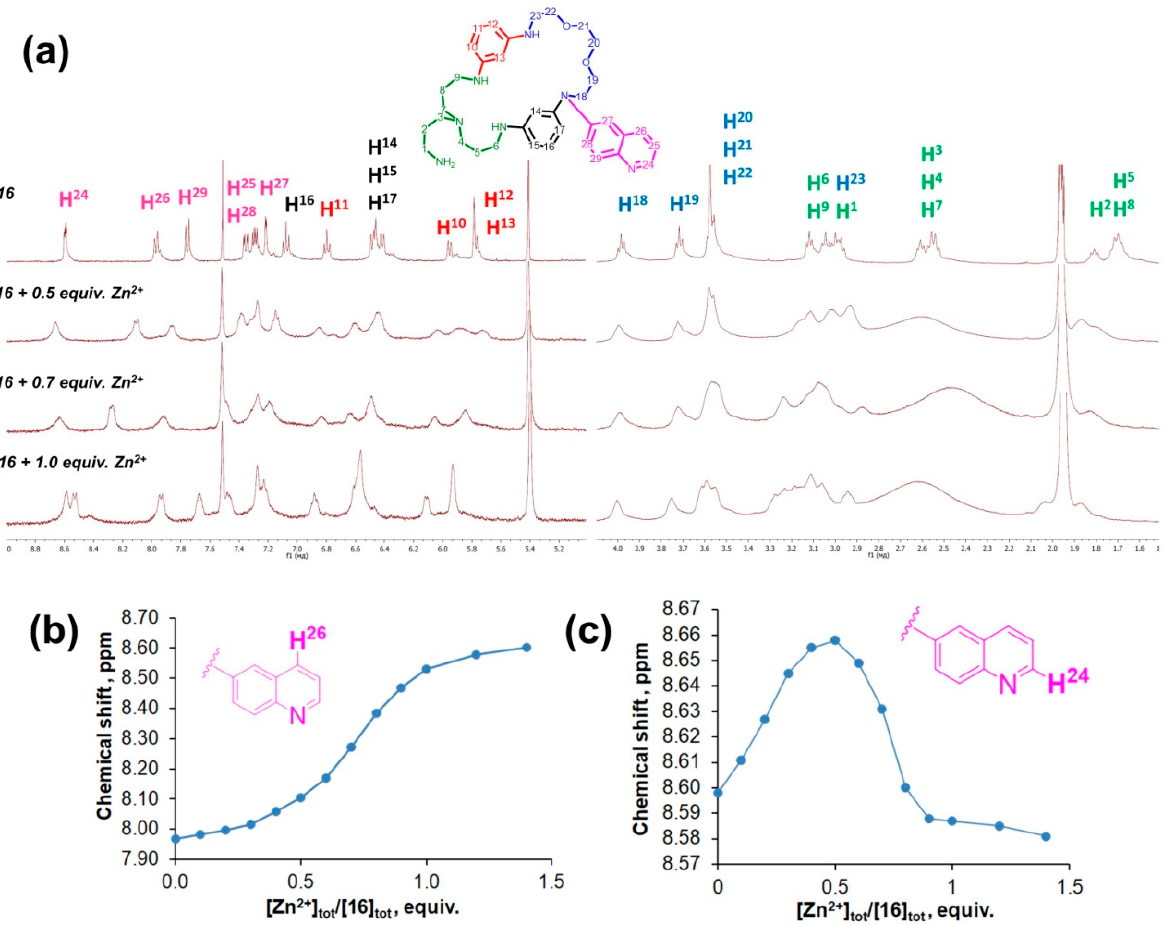
Figure 3. NMR titration of compound 16 with Zn(ClO 4 ) 2* 6H 2 O in CD 3 CN, C L 0.041 M and C Zn(II) 0.2 M. ( a ) NMR spectra of 16 after the addition of 0.5, 0.7 and 1 equiv. of Zn(ClO 4 ) 2 ; ( b ) changes in the chemical shift of the H4(Quin) proton; ( c ) changes in the chemical shift of the H2(Quin) proton.